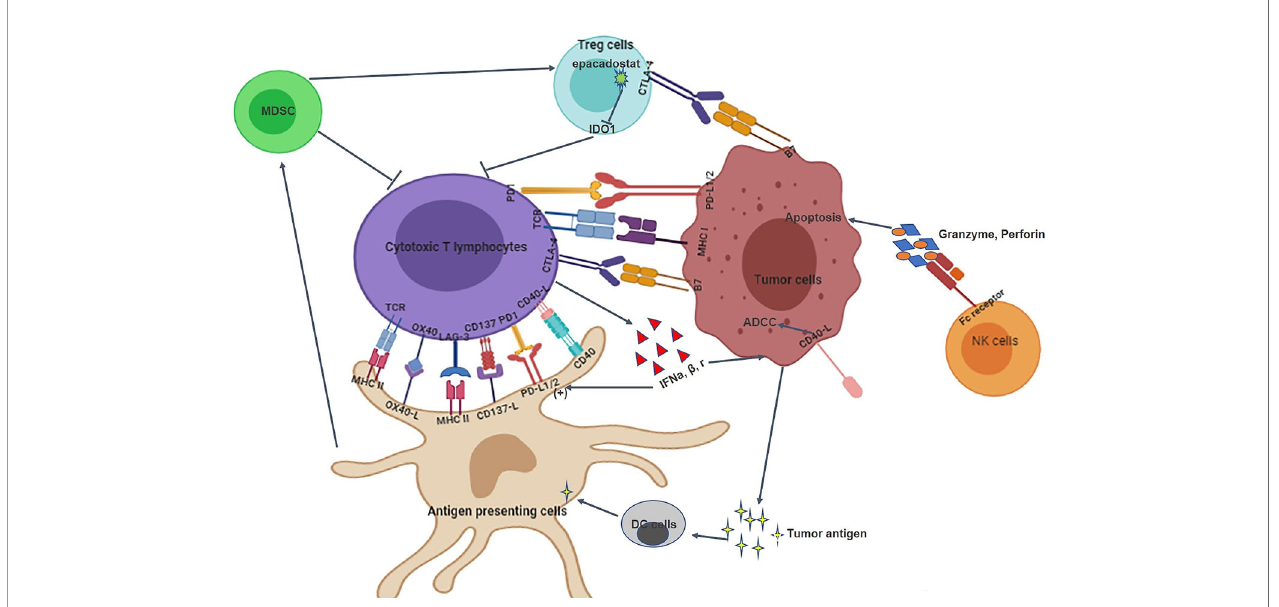
FIGURE 1 | The interaction between HNSCC tumor cells and the immune system. 1) The immune system of HNSCC tumor tissues includes immune cells, immune checkpoints, and immune microenvironment; 2). Immune checkpoints such as PD-1/PD-L1 and CTLA-4/B7 can inhibit the proliferation and in fi ltration of cytotoxic T lymphocytes; 3) MDSC, Treg cells, NK cells and cytotoxic T lymphocytes are involved in the elimination of tumor cells; 4) Tumor cells and immune cells can also interact with each other through